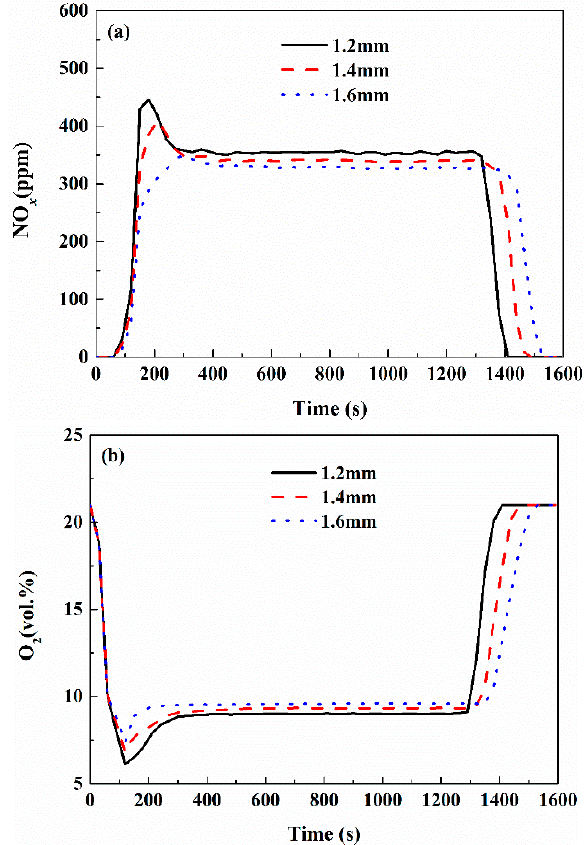
Figure 8. NO emissions ( a ) and O 2 content ( b ) of flue gas with different coke particle sizes.